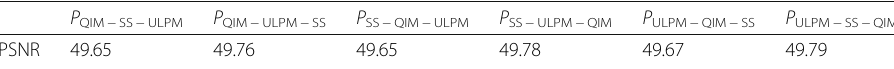
Table 3 Impact on clean